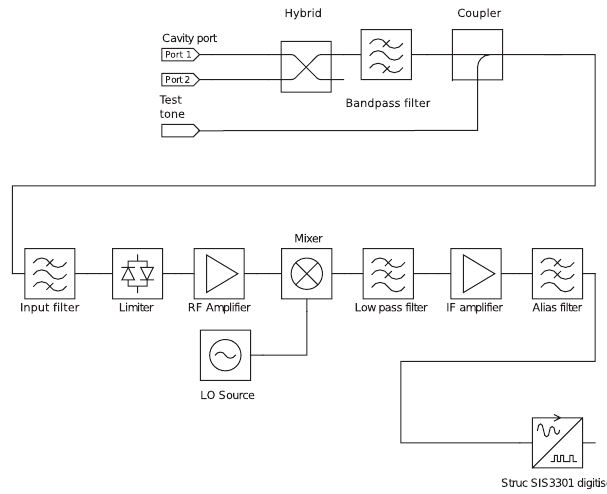
FIG. 5. Schematic of rf signal processing electronics for the C -band system. The S -band system lacks the initial combiner hybrid and